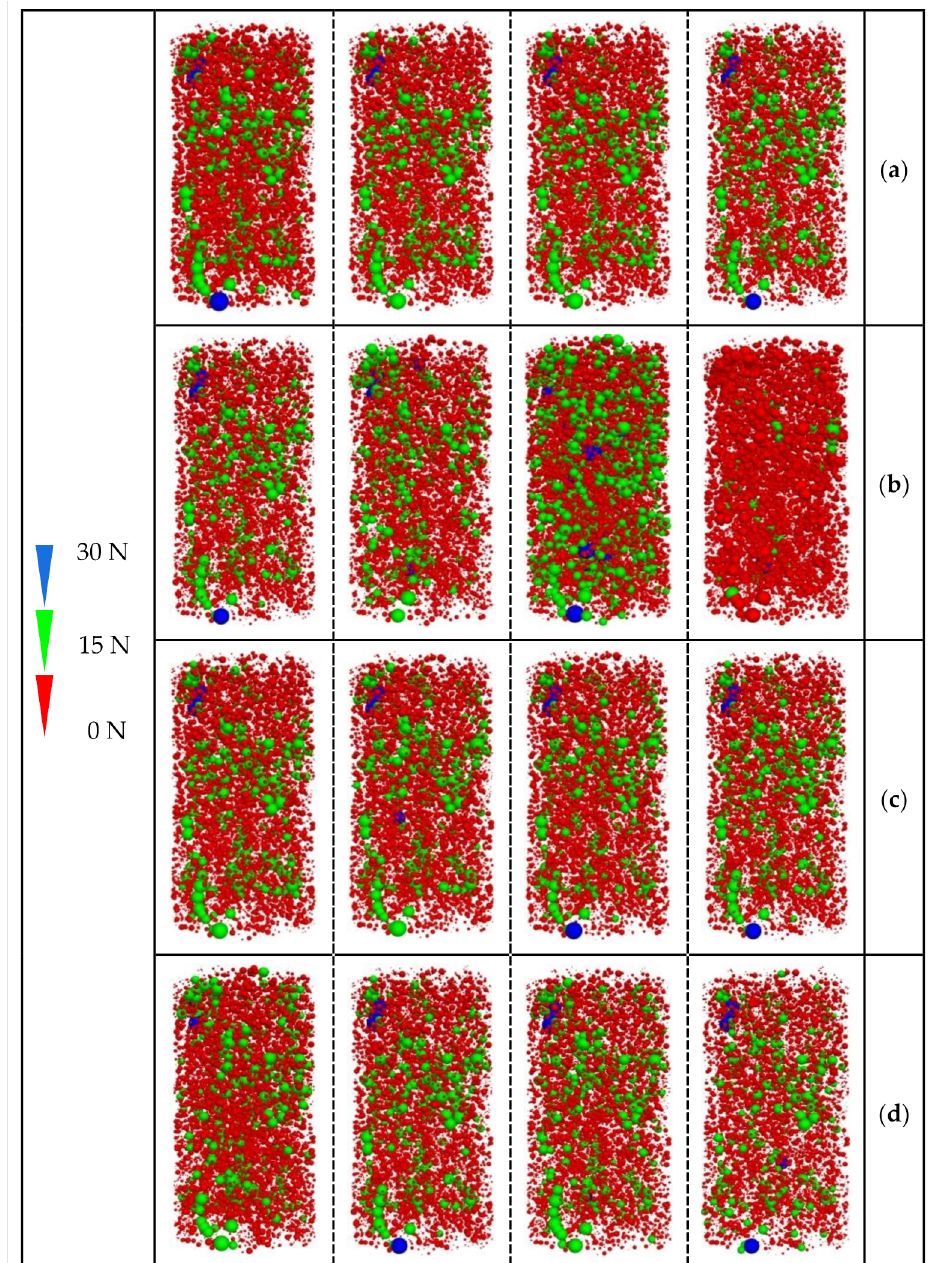
Figure 14. Variation diagram of force chain network; ( a ) Force chain varies with frequency; ( b ) Force chain varies with excitation force; ( c ) Force chain varies with amplitude; ( d ) Force chain varies with vibration